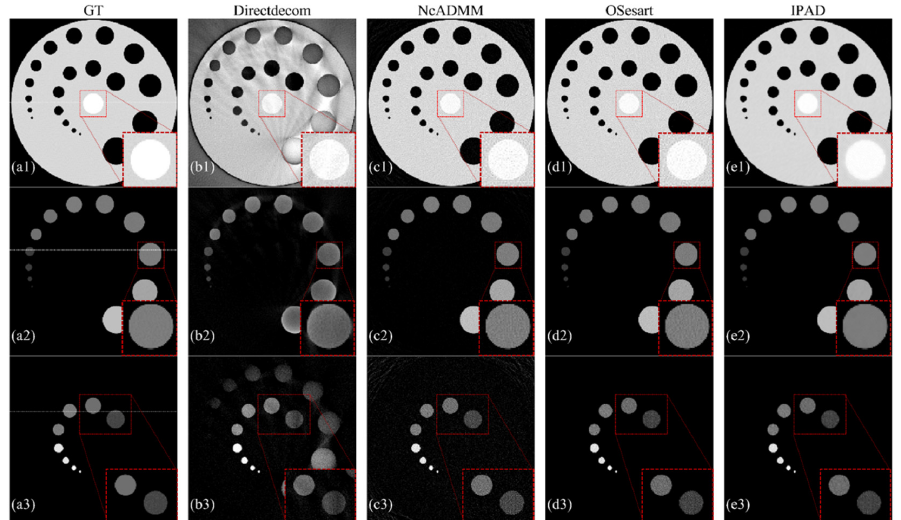
Figure 7. Results of simulation dataset obtained by different methods with adding noise (I 0 = 1 × 10 6 ).( a1 )–( a3 ), ( b1 )–( b3 ), ( c1 )–( c3 ), ( d1 )–( d3 ), and ( e1 )–( e3 ) represent the tissue, bone, and iodine ob- tained by the GT, Directdecom, NcADMM, OSesart, and the proposed IPAD method, and their cor- responding enlarged images, respectively. The display windows of the three materials are [0.01 1], [0.01 1], and [0.01 0.5],